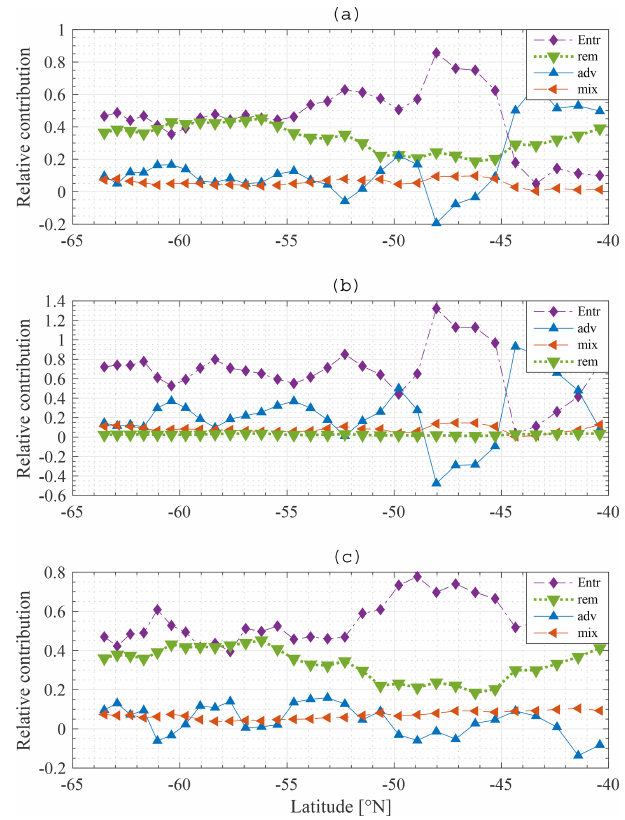
Figure 11. Model result: relative contribution of entrainment ( (cid:7) ), diffusive mixing ( (cid:74) ), remineralisation ( (cid:72) ) and advection–upwelling ( (cid:78) ) to restoration of the winter nitrate (a) , silicate (b) and iron (c) concentrations at each station along the average meridional sec-